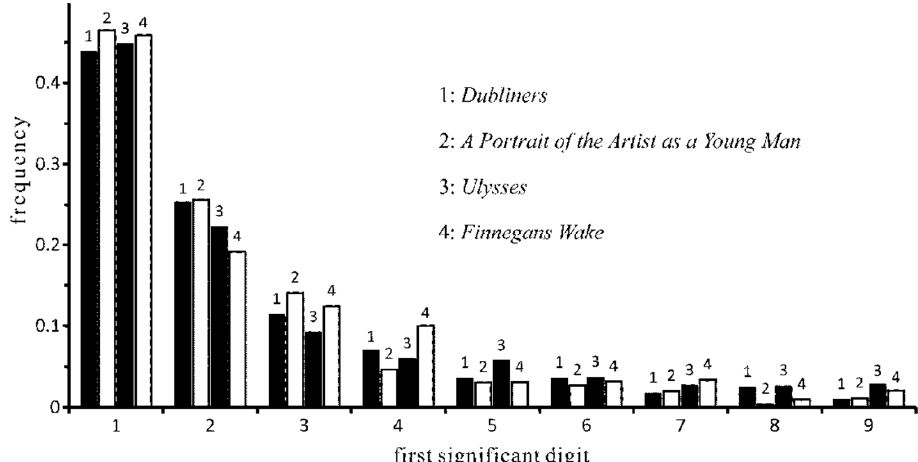
Figure 7. The distribution of the first significant digits of numerals in Joyce’s texts. Note two outliers, corresponding to the significant digit one, for texts not completely written by Stevenson (Figure 8).